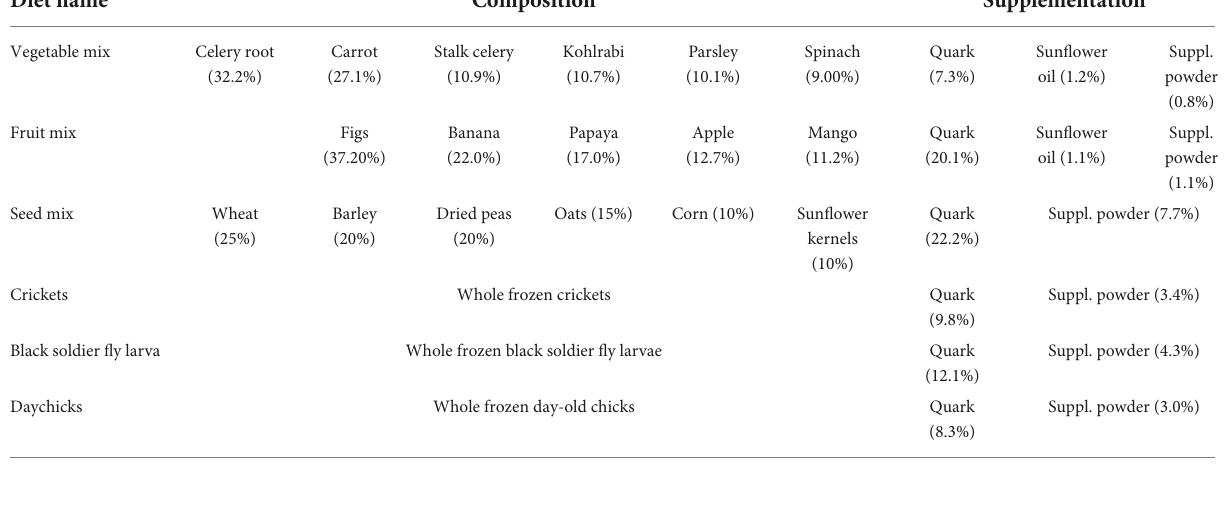
TABLE 1 Composition of experimental diets (weight %) and supplementation in % fresh weight.